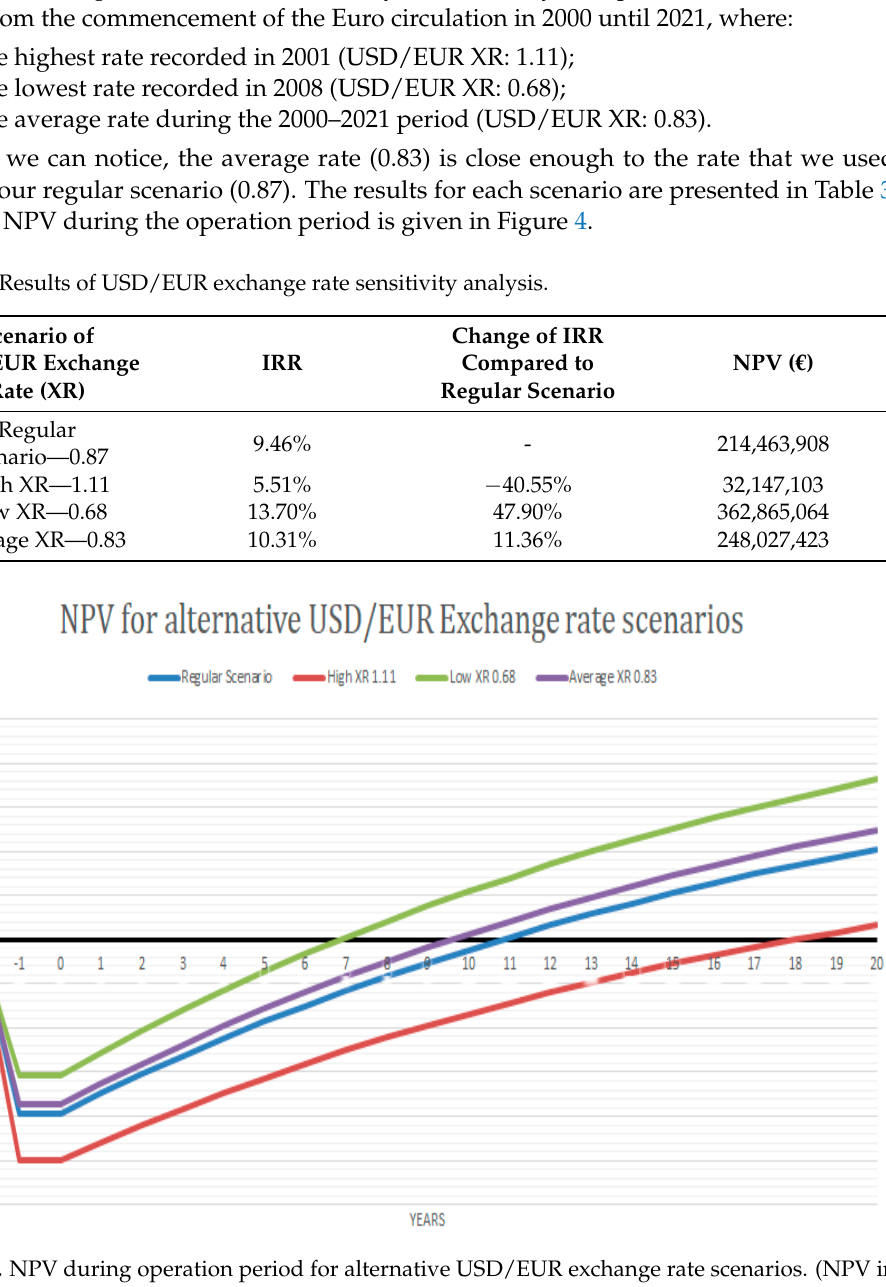
Figure 4. NPV during operation period for alternative USD/EUR exchange rate scenarios. (NPV in million Euro).